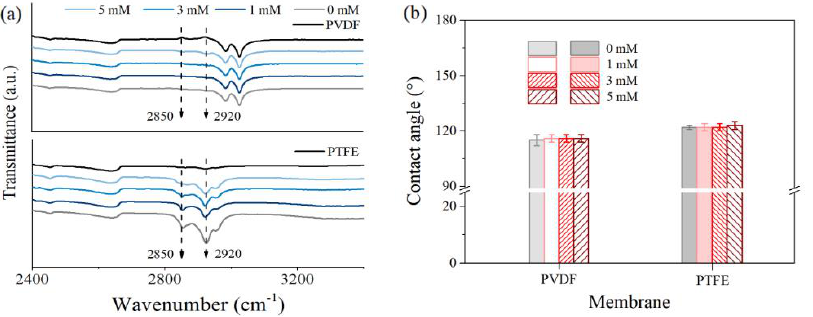
Figure A1. Contact angles of DI water, 0.5 mM SDS, and 0.8 mM SDS for the PVDF and PTFE membranes.